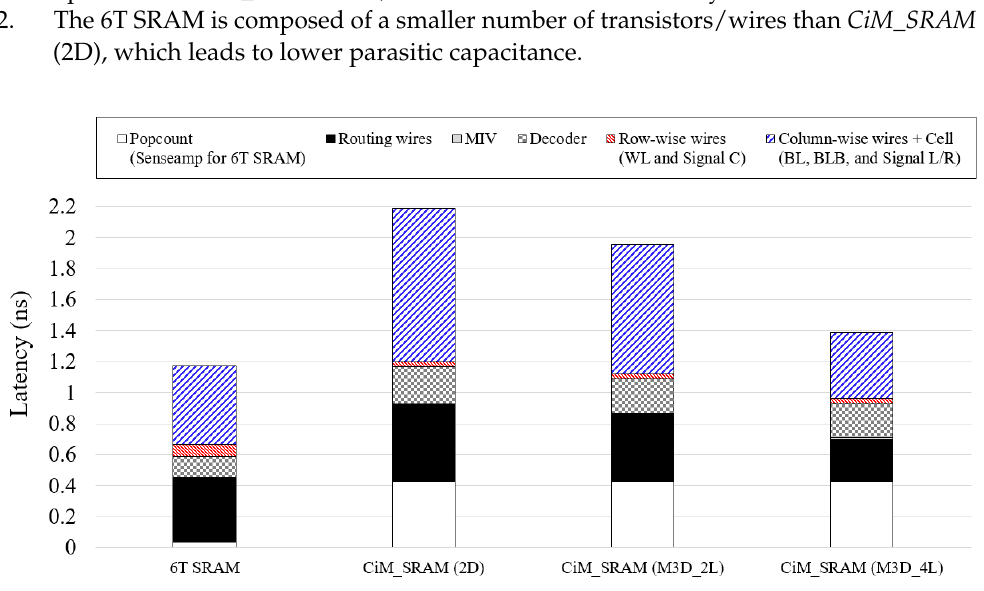
Figure 5. Latency of different SRAM designs (Note the latency value for 6T SRAM represents read latency and those for three different CiM_SRAMs are XAC operation latencies).